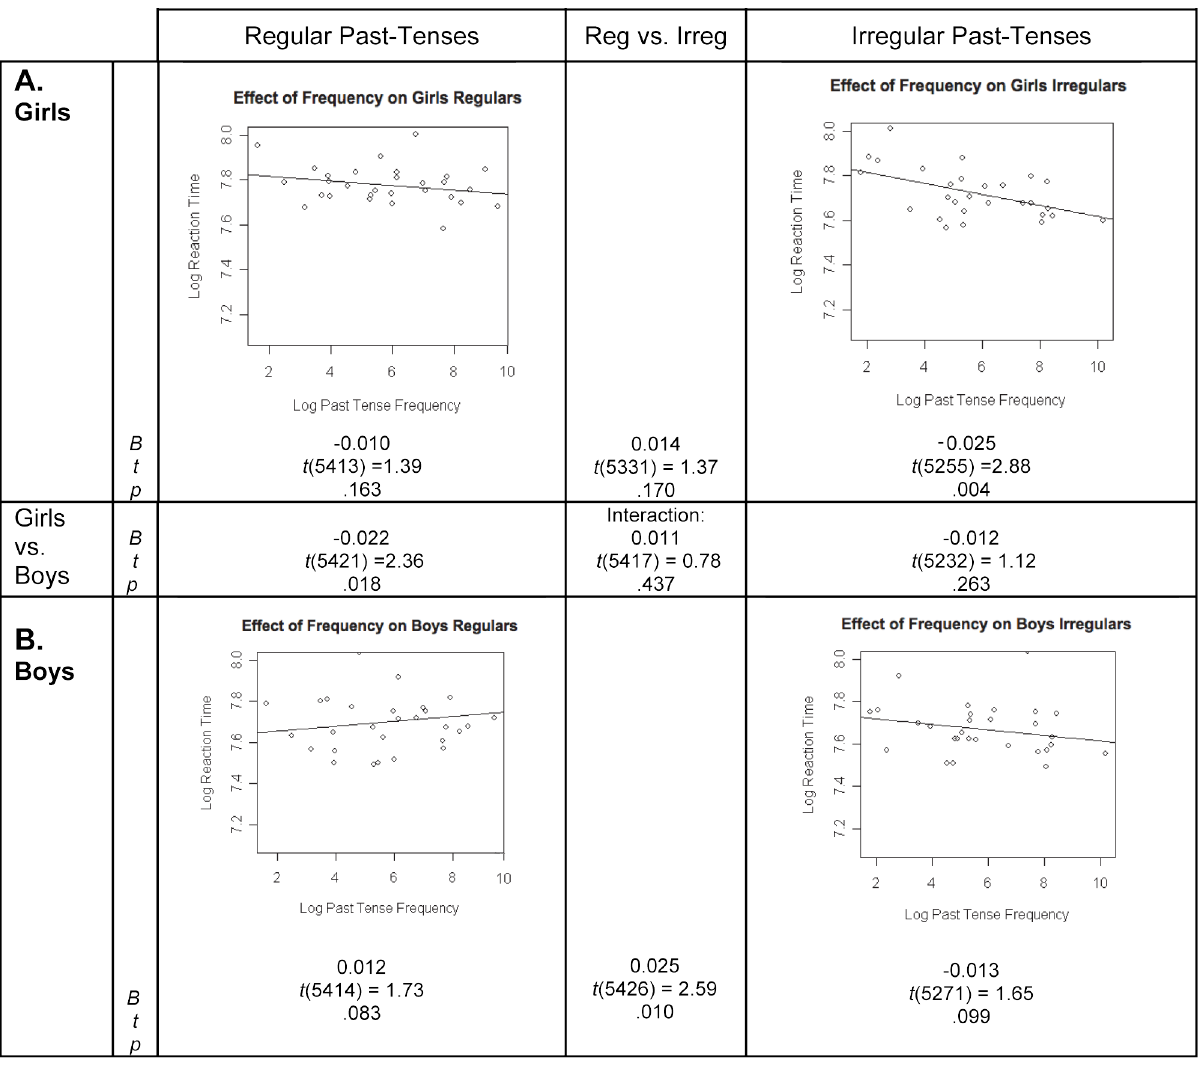
Figure 3. Children’s frequency effects for regular and irregular past-tense forms, by sex. In each scatterplot, the line represents the prediction of the mixed effects regression model with regard to the effect of frequency on the natural logarithm of response times, with the effect of all covariates removed. Points on the graph represent residuals from the model (with the effects of the covariates removed) for the 29 regular and 29 irregular verbs. B represents the unstandardized regression coefficient, indicating the slope of the regression line, t represents the t -statistic of the comparison between B and zero, and p represents the statistical significance of this comparison.